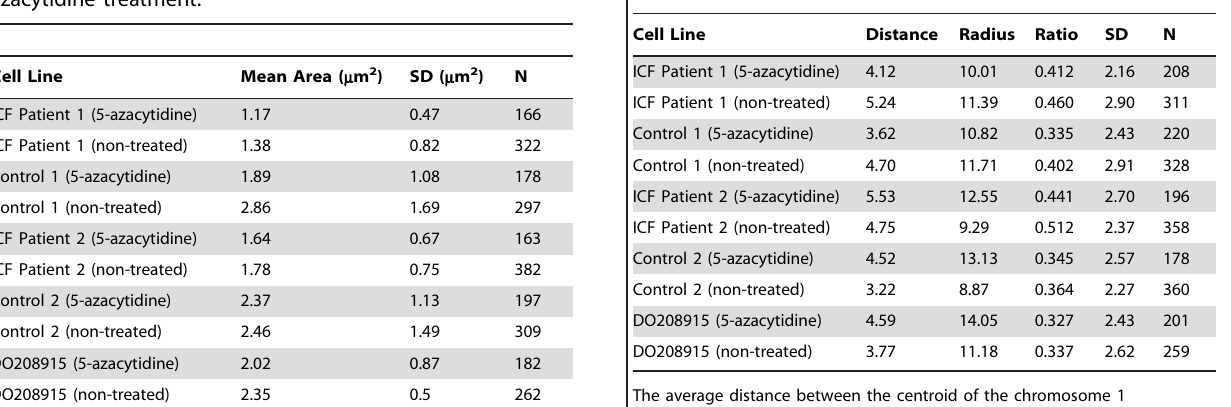
Figure 9. Changes in chromosomal methylation patterns upon treatment with 5-azacytidine. Control cells were treated with the demethylating agent 5-azacytidine and subsequently immunostained with a monoclonal antibody against 5-Methylcytidine (red signal). A significant variability in terms of extent and distribution of DNA methylation within the cell populations (Control 1: A, B and C; Control 2: D, E and F) was observed, with some metaphases and nuclei showing almost no methylation at all and others showing still substantial methylation, particularly on the compact heterochromatic areas (white arrows). However, stretched or decondensed heterochromatin in metaphase appeared to be consistently demethylated (white stars). Arrows and stars point specifically to chromosome 1 juxtacentromeric heterochromatin. doi:10.1371/journal.pone.0011364.g009 Table 2. Heterochromatin positioning before and after 5- azacytidine treatment. Table 1. Heterochromatin configuration before and after 5- azacytidine treatment.